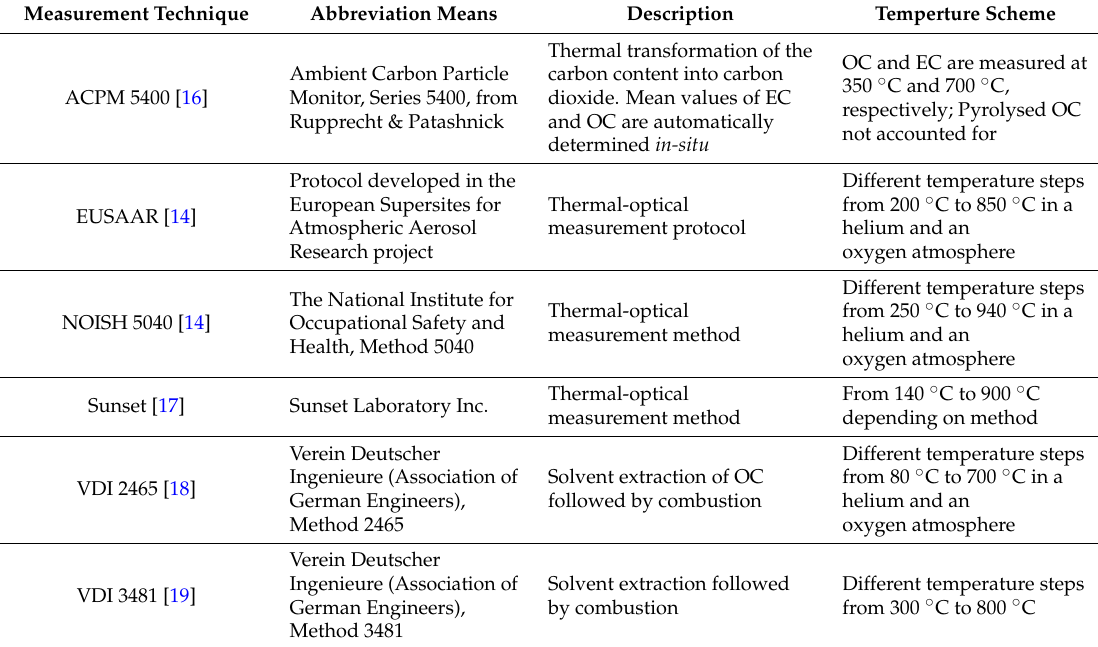
Table 1. A description of the different techniques to measure